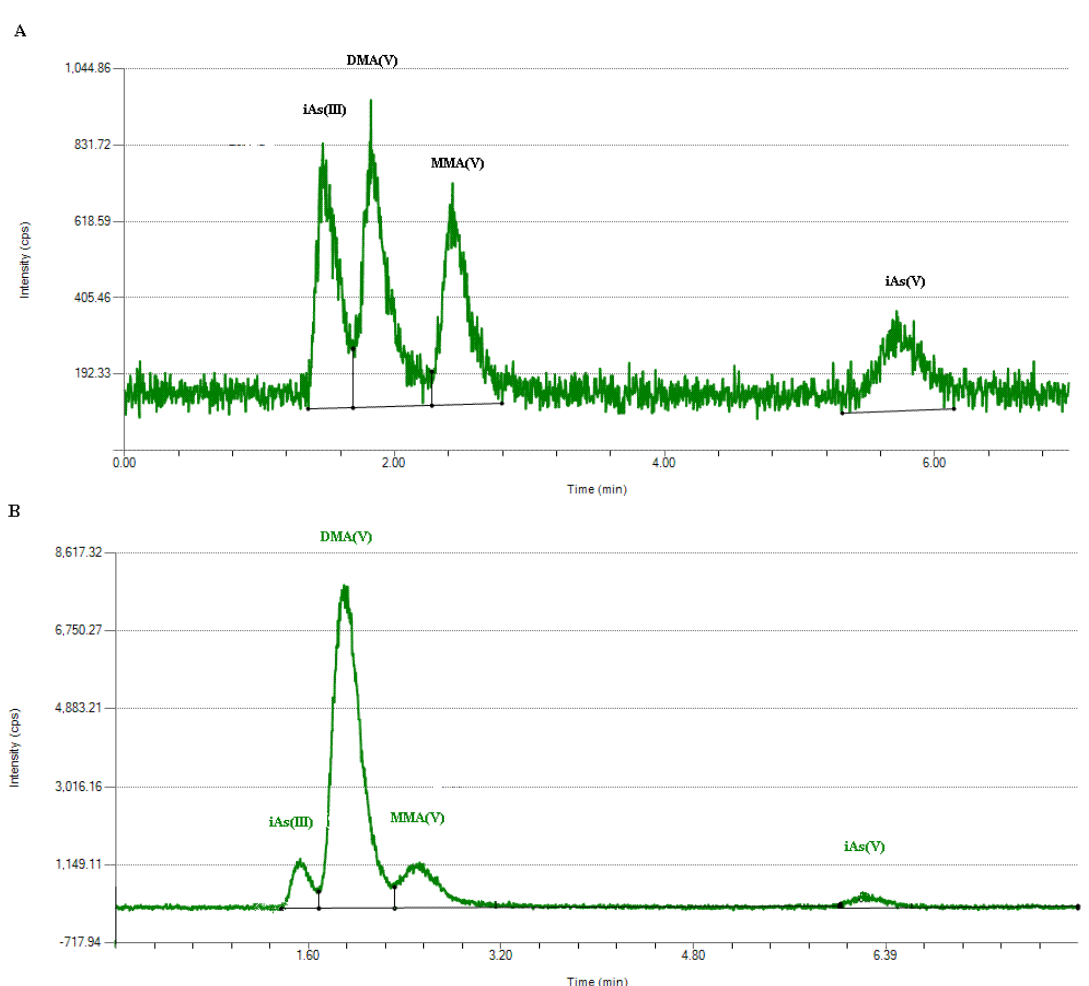
Figure 2. Chromatogram of four arsenic species ( A ) in standard mixture in deionized water; ( B ) in a urine